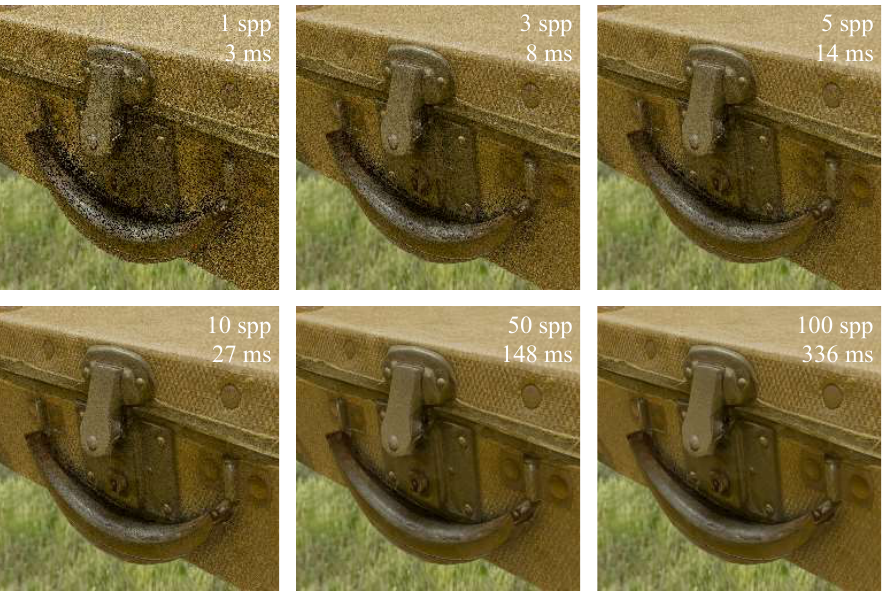
Figure 3. Results of different ray sampling counts: High samples per pixel (spp) values give high quality images, with large amount of computing time (in